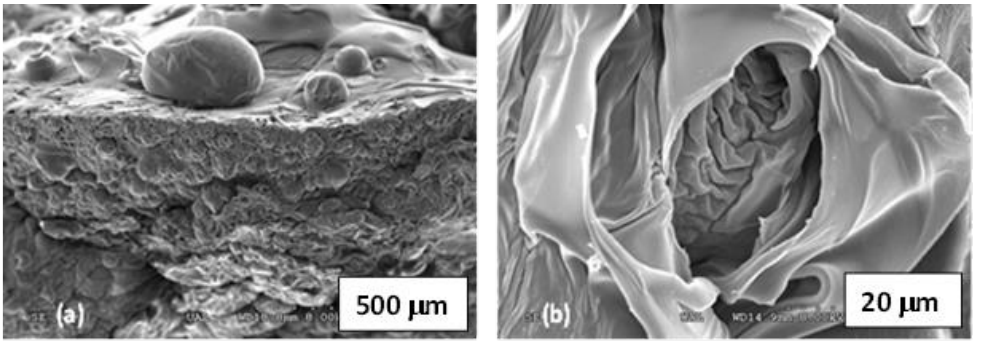
Figure 3. SEM images in aerogel SLC- systems: ( a ) SLC-NMBA, ( b ) SLC-EGDMA.